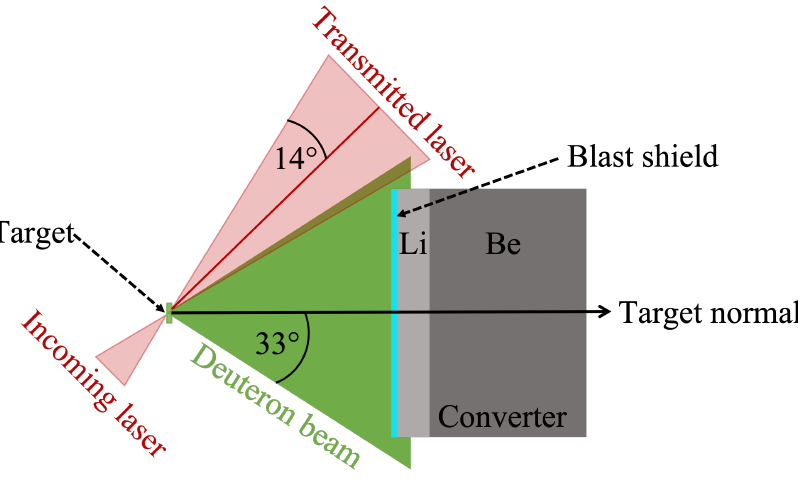
Figure 3. Top view of the setup (target size not to scale). The converter is placed in the target normal direction to capture the ion beam but outside the transmitted laser cone ( f /2) to avoid